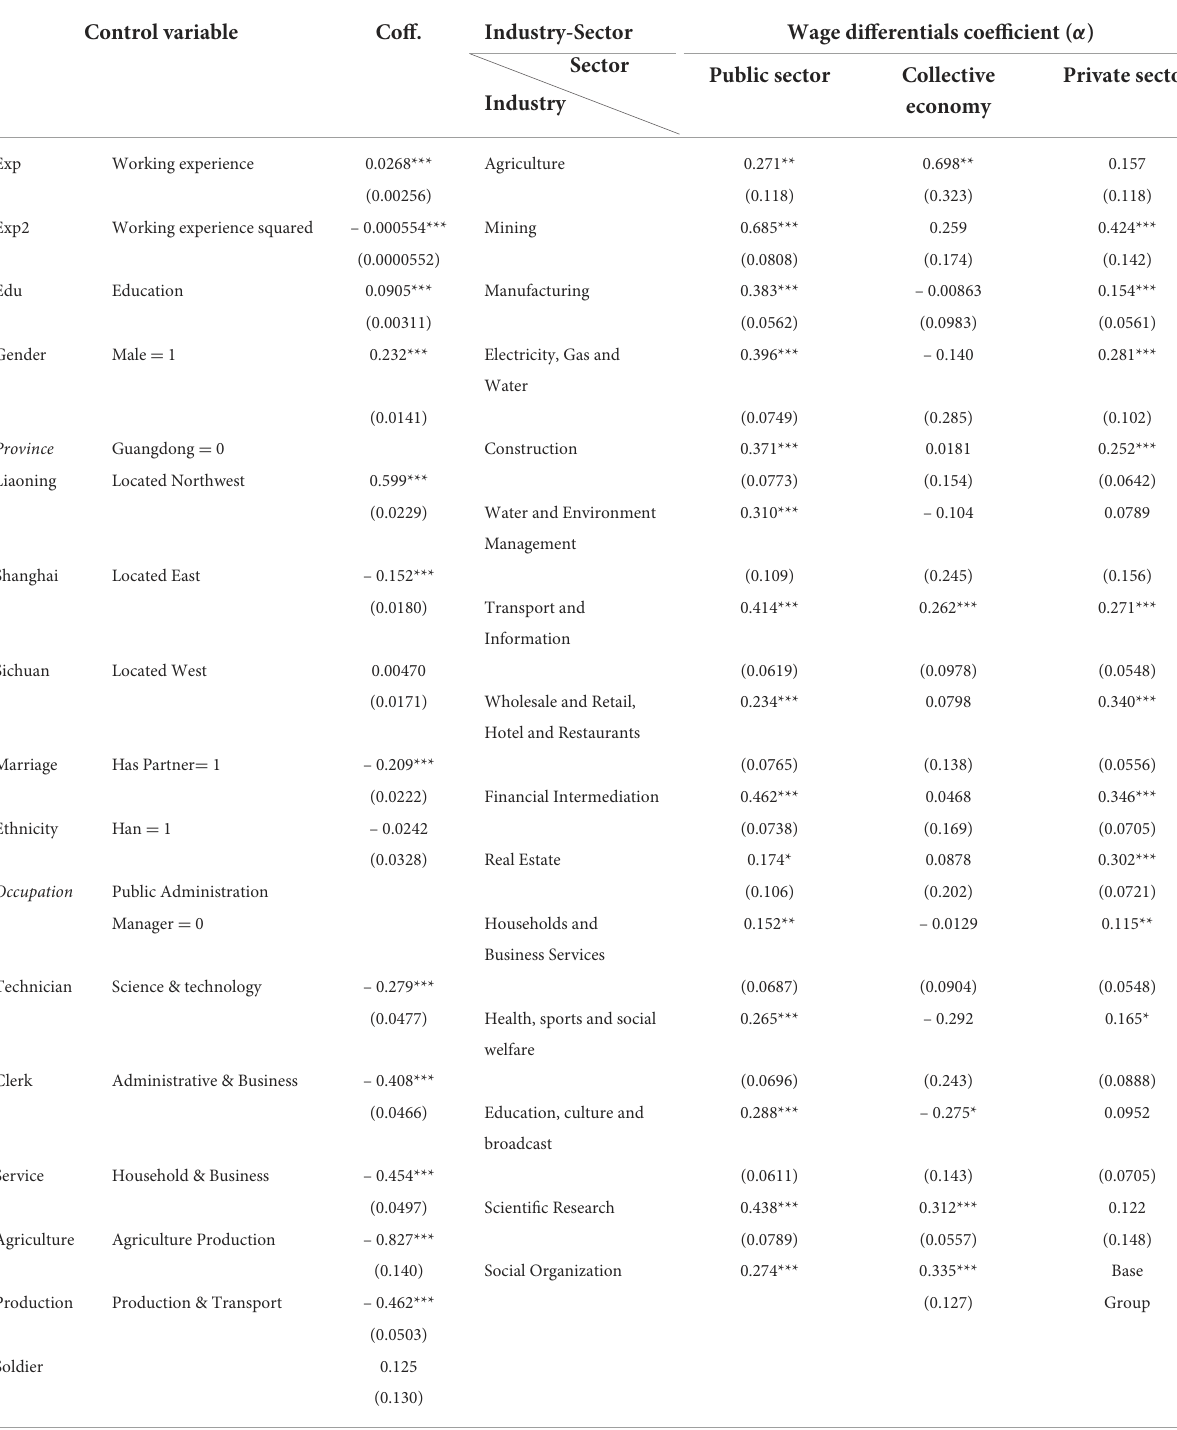
TABLE 4 First-stage estimation for